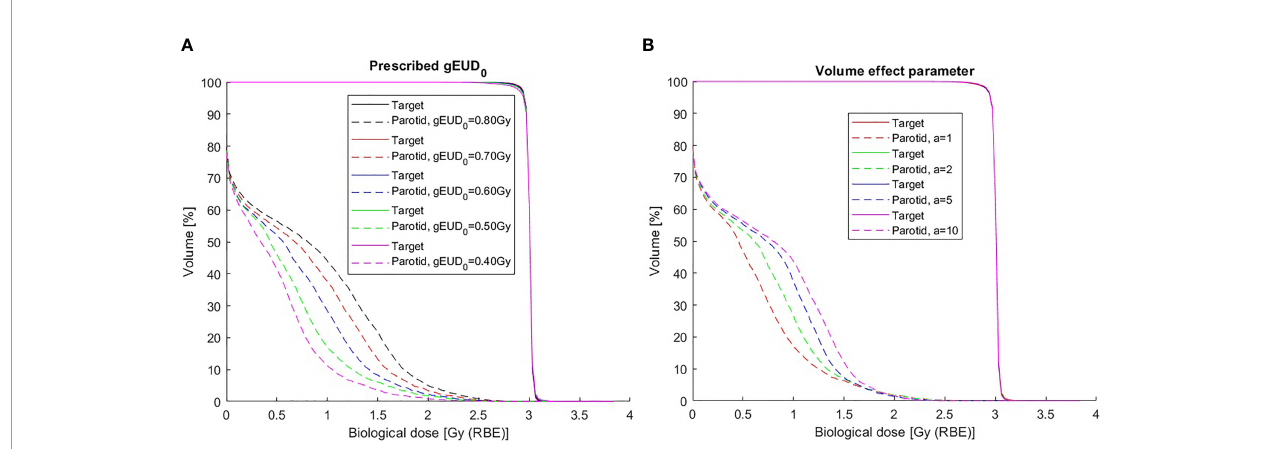
FIGURE 2 | Dose – volume histograms for a chordoma patient (same as in Figure 3 ). (A) For different gEUD 0 to the parotid. Cost function parameters: D pre = 3.00 Gy, w T = 1 (target); w OAR = 20 , gEUD 0 = 0.80, 0.70, 0.60, 0.50, 0.40 Gy, and a = 1 (parotid). (B) For different a values of the parotid. Cost function parameters: D pre = 3.00 Gy, w T = 1 (target); w OAR = 20 , ( gEUD 0 , a ) = [(0.50 Gy, 1), (0.80 Gy, 2), (1.15 Gy, 5), (1.45 Gy, 10)]